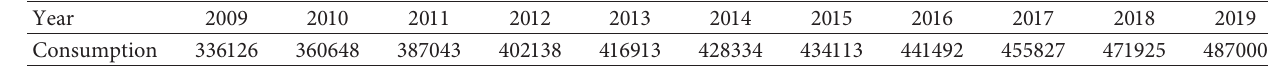
Table 1: China’s total energy consumption between 2009 and 2019 (10000 tce).